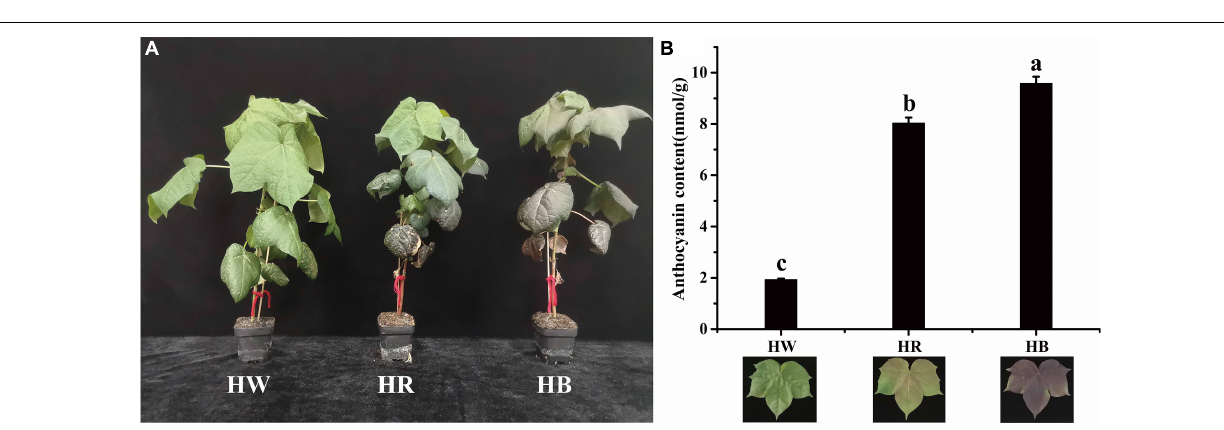
FIGURE 2 | Cotton seedlings under different light treatments and their corresponding anthocyanin content. (A) Phenotypes of Huiyuan under different light treatments. (B) Anthocyanin content of Huiyuan leaves under different light treatments. HW, HR, and HB indicates samples treated by white light, red light, and blue light, respectively. Three biological replicates of each treatment were analyzed. Data are expressed as the means ± SD, n = 3. The letters on top of the bars indicate significance with the same letters being insignificant according to one-way analysis of variance (ANOVA) ( P <